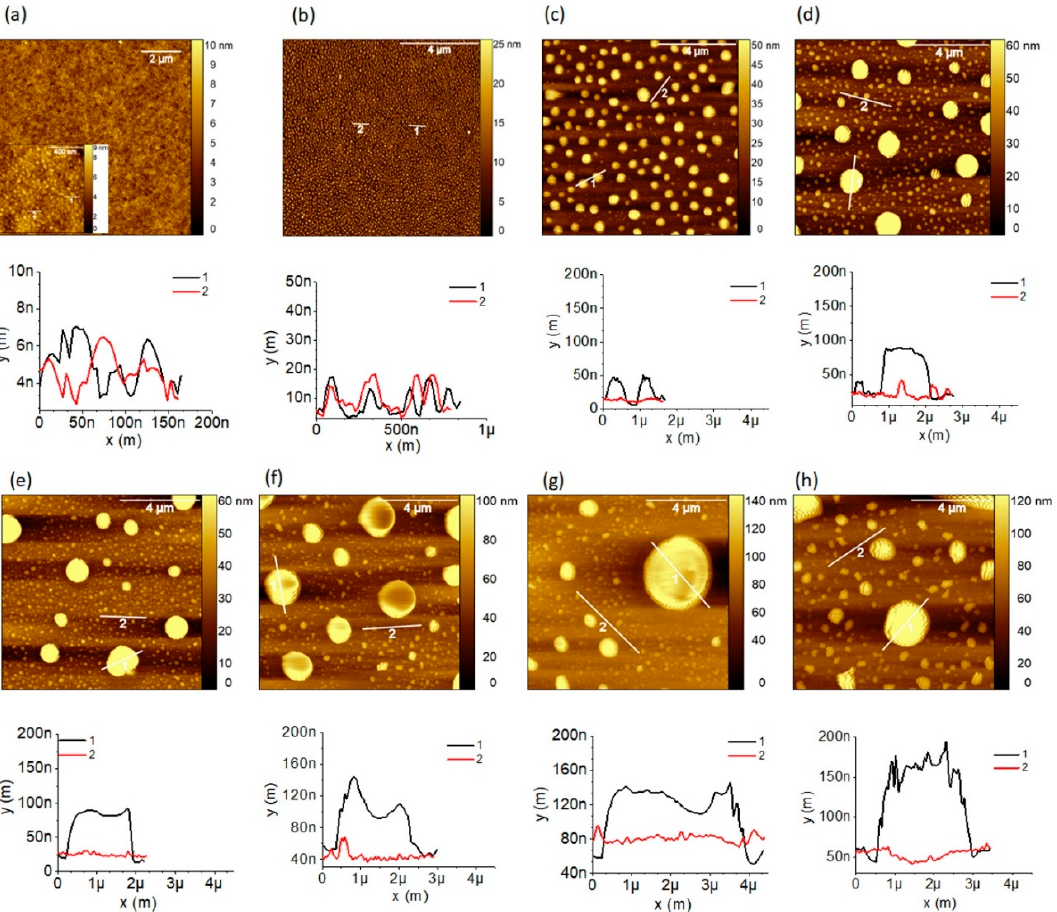
Figure 6. Atomic force microscopy (AFM) images (tapping mode) and the corresponding lateral profile of Cs 2 CO 3 films printed using the ink with 2 mg/mL concentration at different resolutions: ( a ) 100 dpi, ( b ) 200 dpi, ( c ) 300 dpi, ( d ) 400 dpi, ( e ) 500 dpi, ( f ) 600 dpi, ( g ) 700 dpi, and (h) 800 dpi. The scanned area is 10 μ m × 10 μ m. The inset AFM image in (a) is scanned over 1 μ m × 1 μ m. x(m) represents profile line width and y(m) represents profile height.